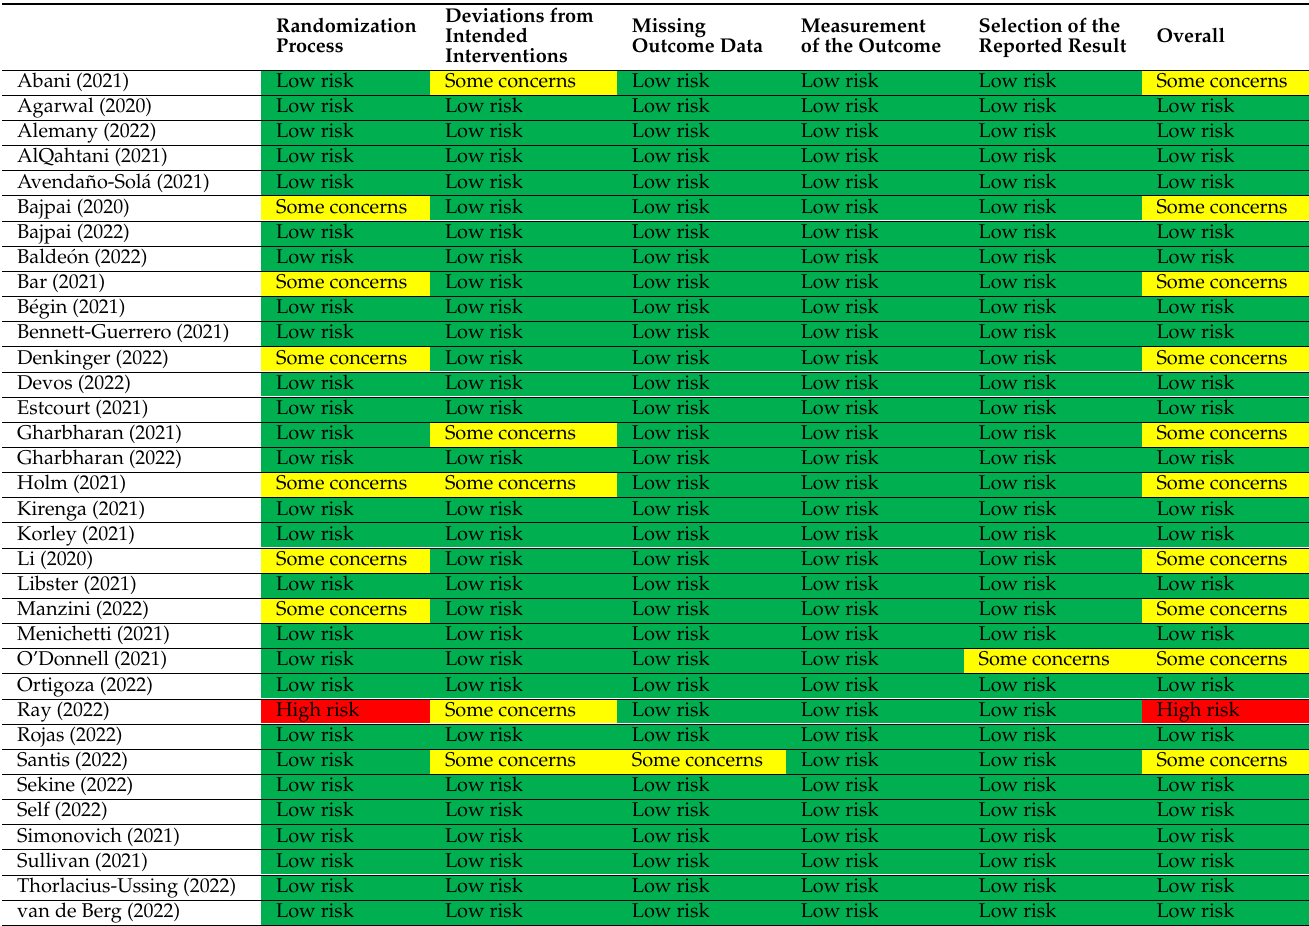
Table 12. Risk of bias assessment based on the RoB:2